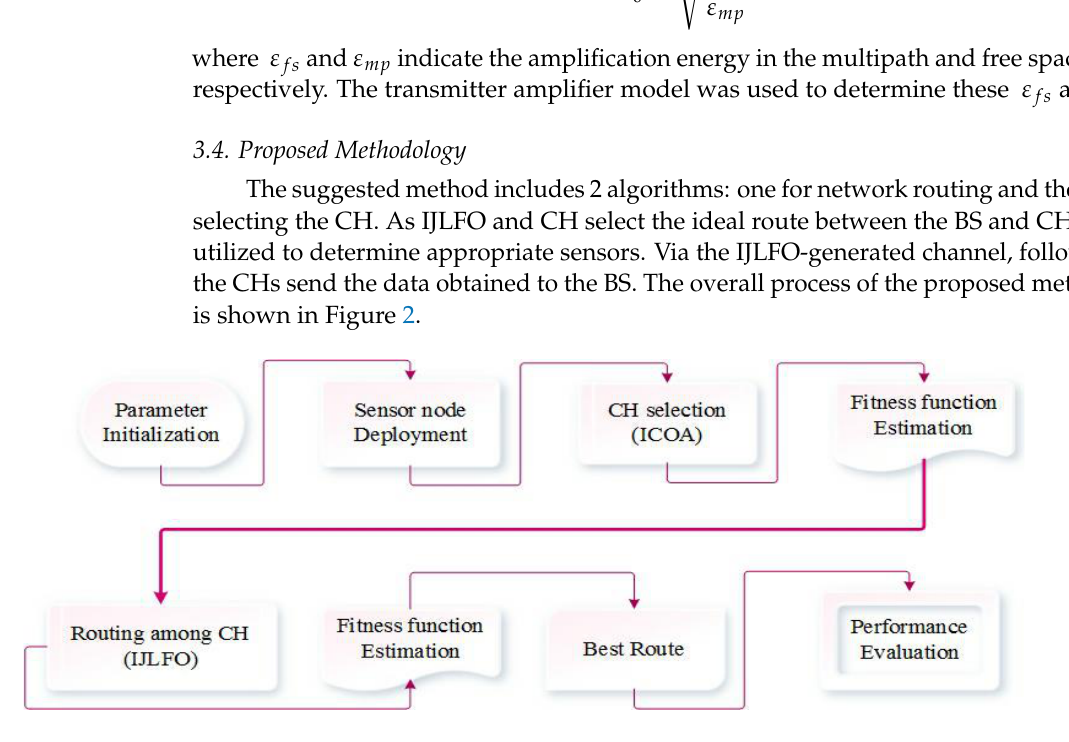
Figure 2. Schematic Block Diagram of Proposed Methodology.